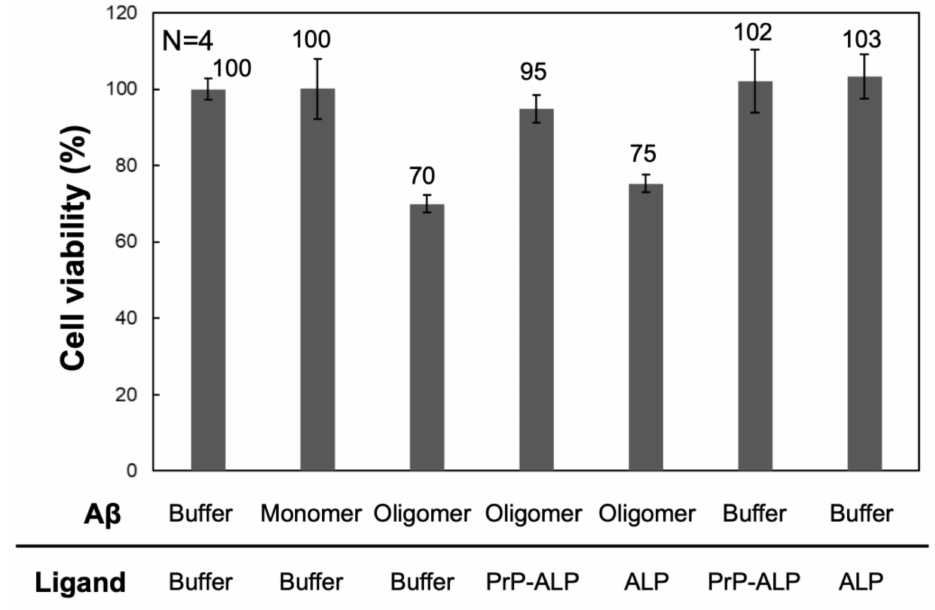
Figure 4. The cell viability measured with MTS assay after the addition of A β oligomers or A β monomers that had been pre-treated with PrP–ALP, ALP, or PBS buffer. We also used PBS buffer instead of addition of A β samples. The data are shown as the mean ± SD in the graph ( n =